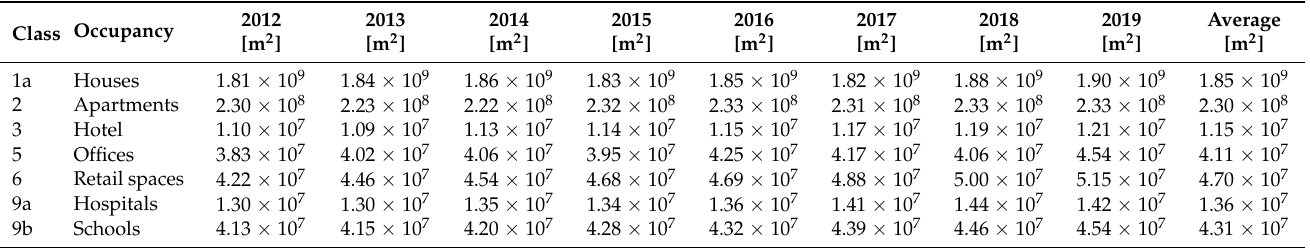
Table 1. Statistical floor areas of various building stocks in Australia from 2012 to 2019 extracted from the Australian Bureau of Statistics and [20].